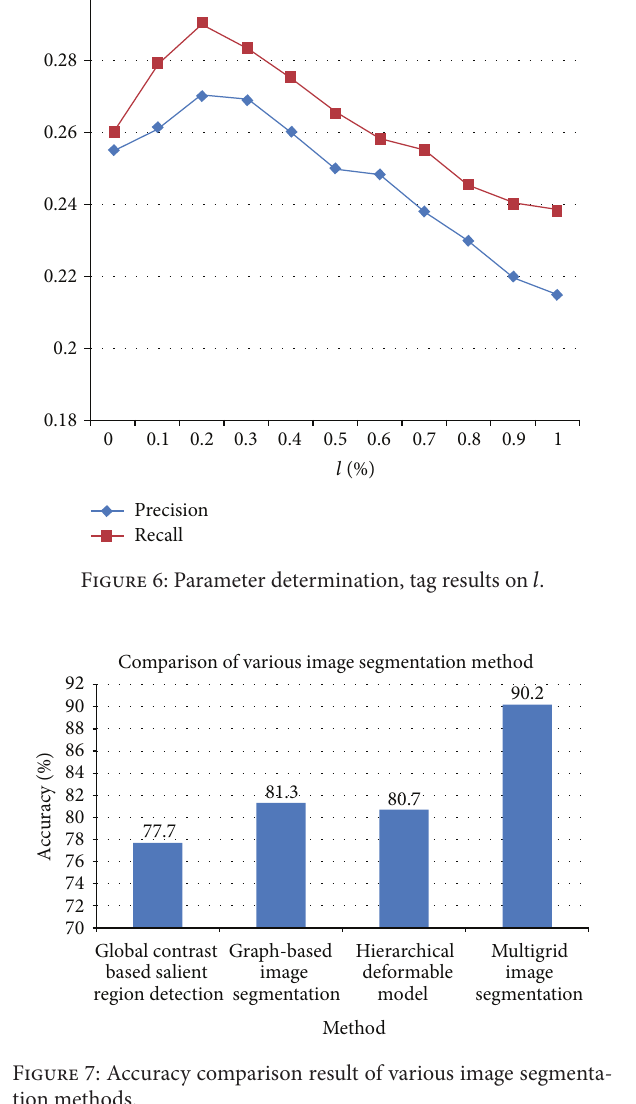
Table 1: Experimental results of image segmentation method